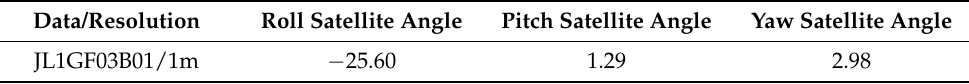
Table 1. Jilin-1 Gaofen 03-1 satellite imagery information.